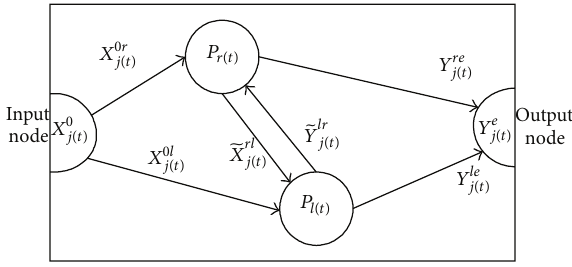
Figure 4: The structure of DN-DEA in one time